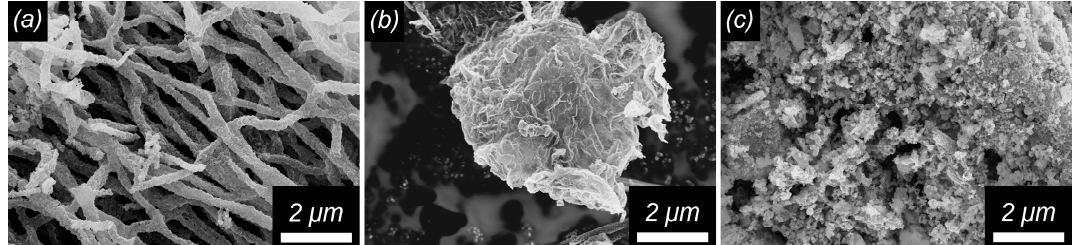
Figure 1. XRD pa tt erns of rGO, ZnO, and ZnO/rGO nanocomposites with di ff erent rGO content. Figure 1. XRD patterns of rGO, ZnO, and ZnO/rGO nanocomposites with different rGO content.